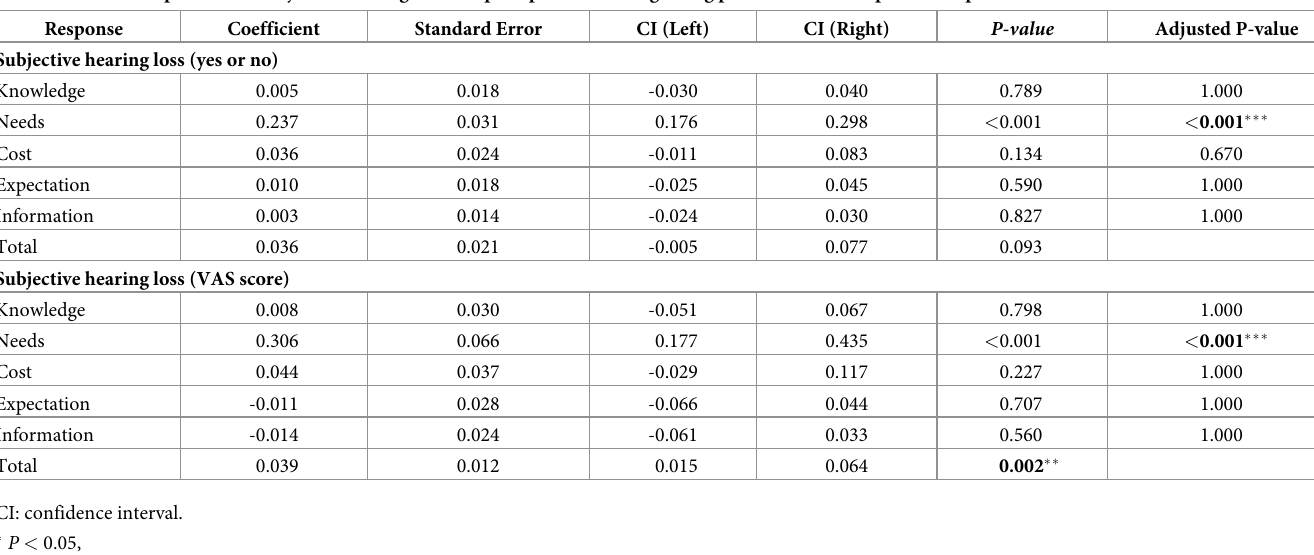
Table 3. Relationships between subjective hearing loss and perception scores regarding personal sound amplification